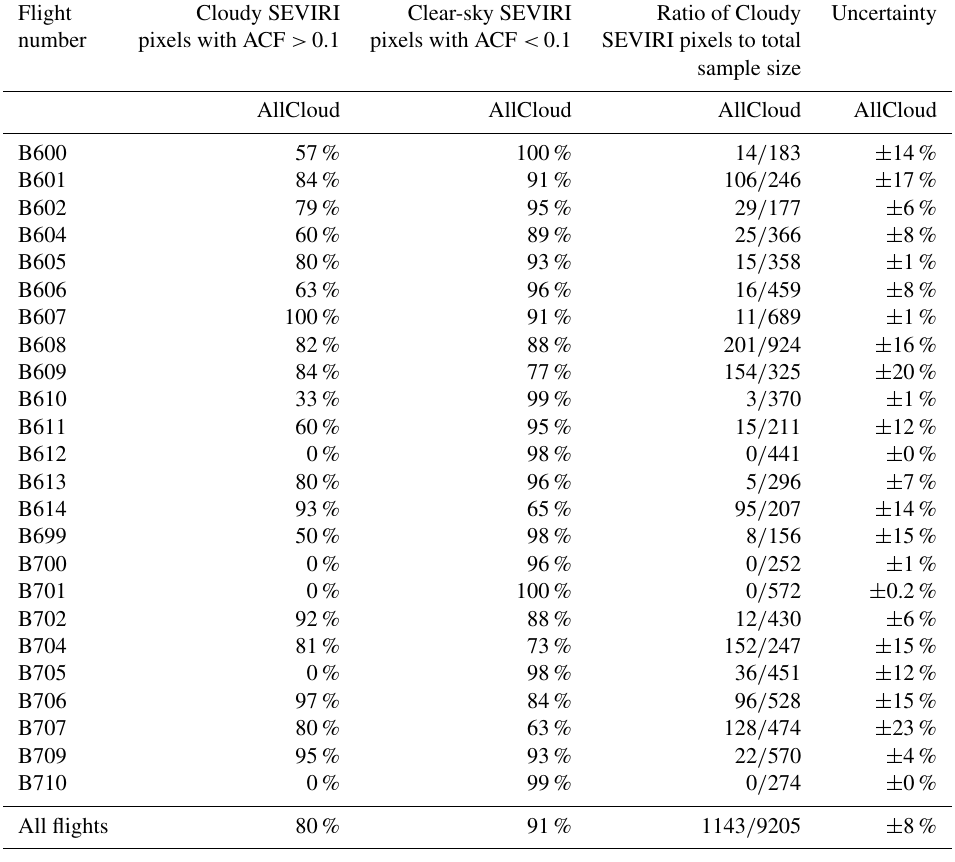
Table 2. Cloud mask matching statistics for the AllCloud SEVIRI cloud mask, sample size for the number of SEVIRI pixels that contain aircraft points, and the temporal measurement uncertainty as described in Sect. 2.5. Aircraft cloud fraction is denoted by ACF. Flight Cloudy SEVIRI Clear-sky SEVIRI Ratio of Cloudy Uncertainty number pixels with ACF > 0.1 pixels with ACF < 0.1 SEVIRI pixels to total